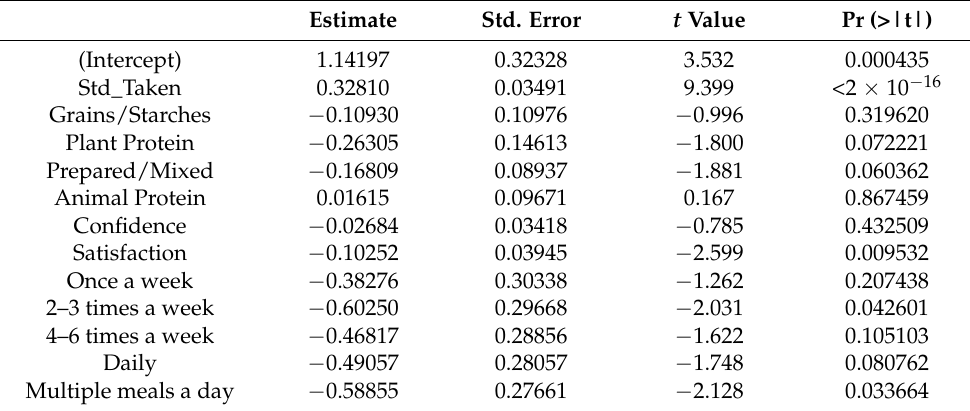
Table 4. Model predicting standardized amount of food wasted regression